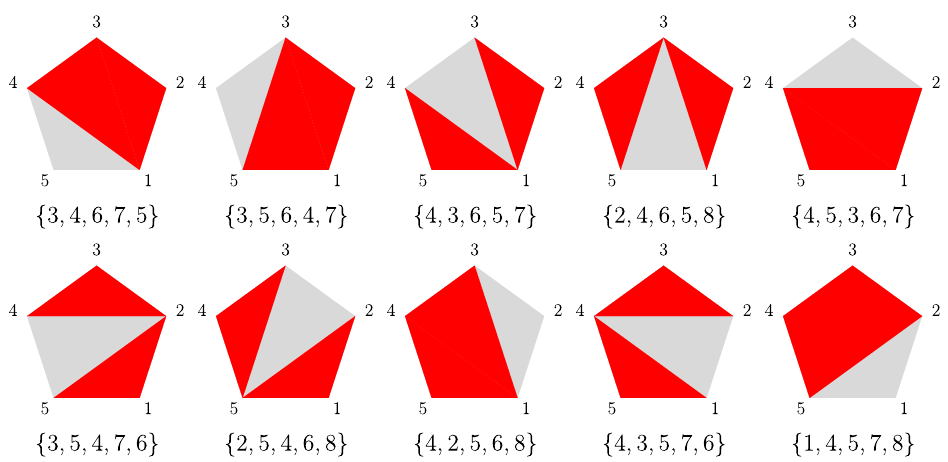
Figure 3 . The 10 generalised triangles for n = 5, k = 2, together with the permutations that label the corresponding positroid cells in the notation of